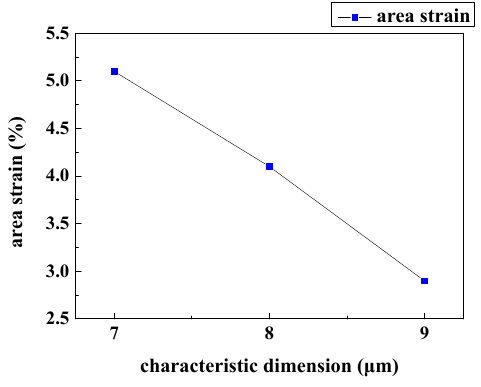
Figure 6. The effect of the characteristic dimension on the basic area strain of WBCs traversing slit-shape patterned microfilters.